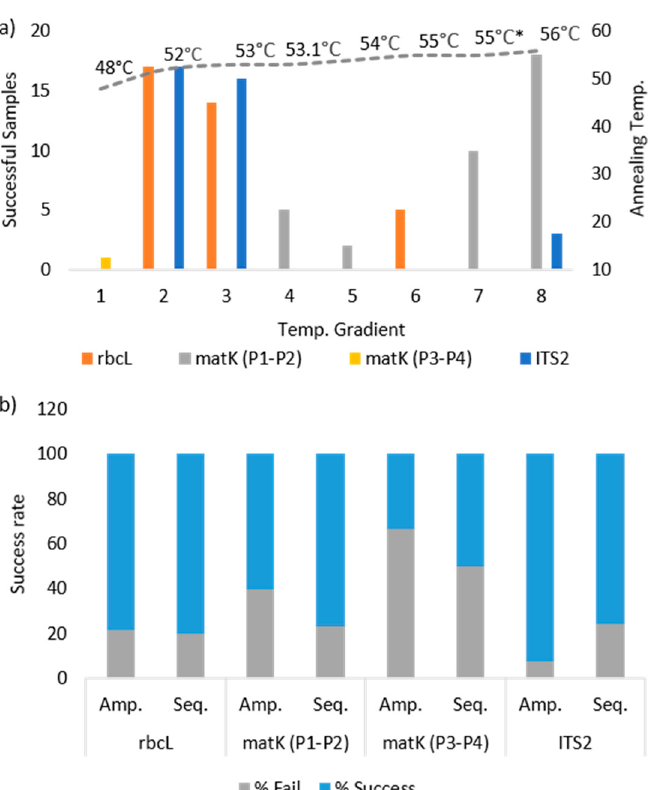
Figure 2. PCR amplification and sequencing success rate for the DNA barcode markers. ( a ) Annealing temperature gradients used for the barcode amplification, (* represents the dual annealing temperature 50|55 °C), ( b ) PCR amplification and sequencing success of the attempted samples.